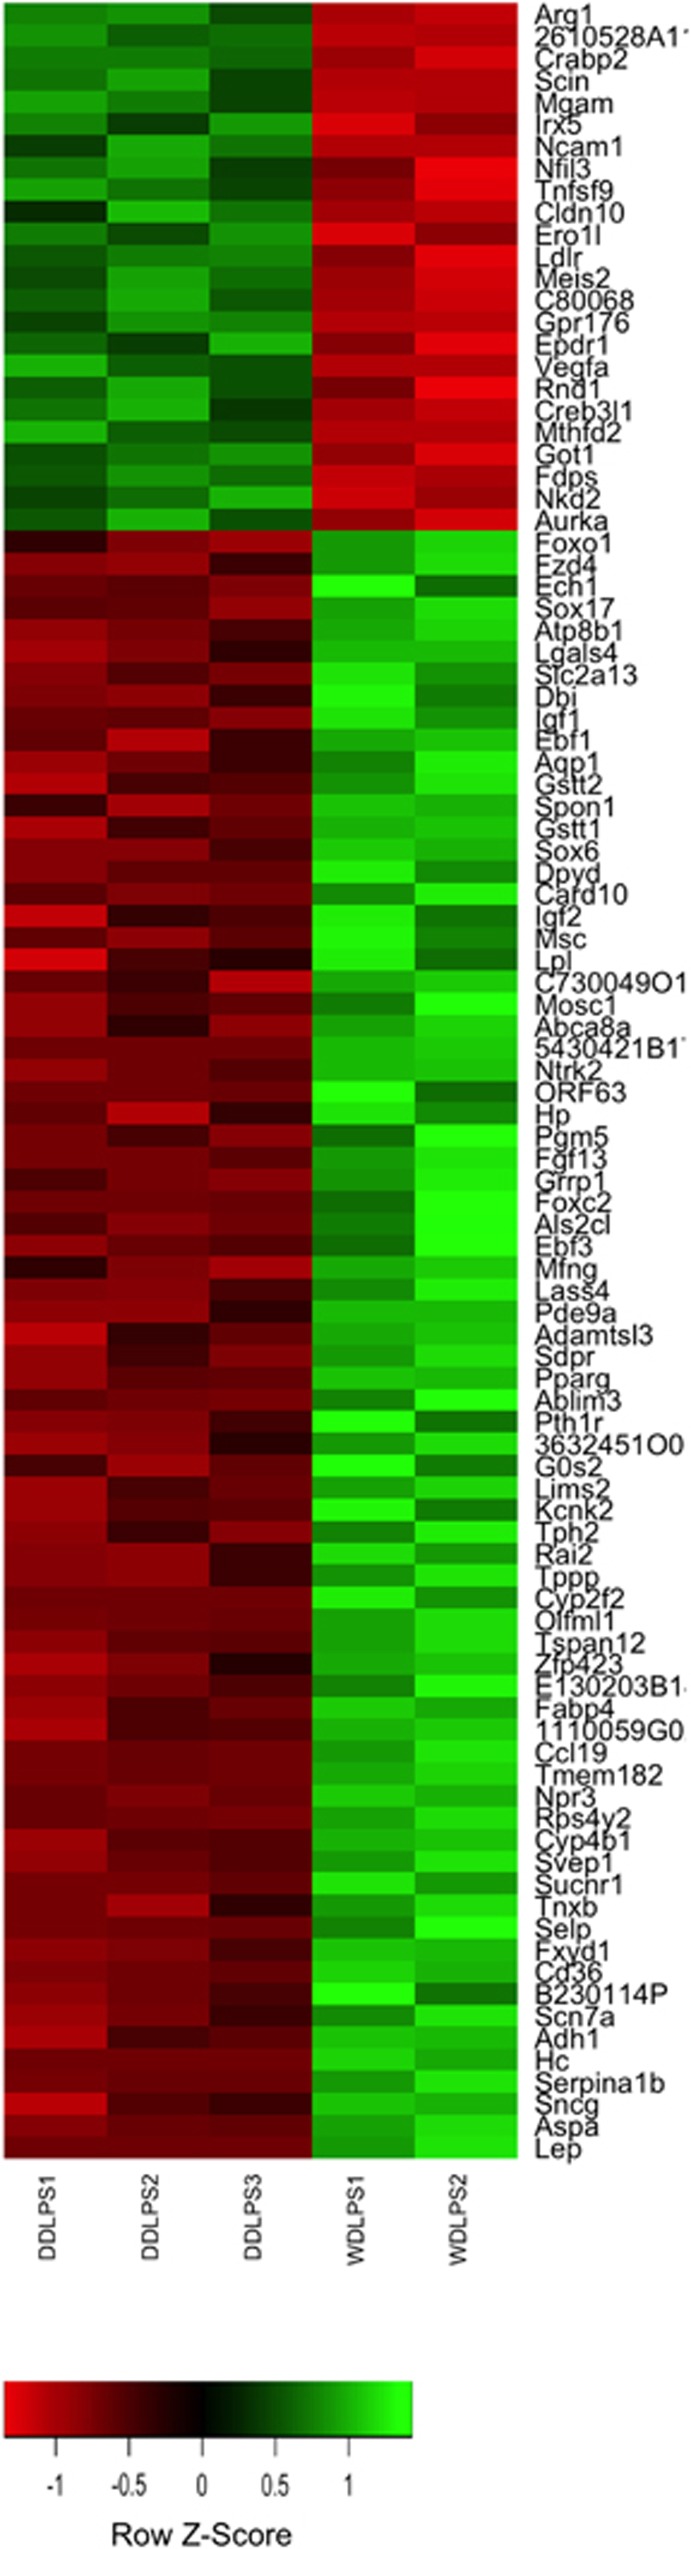
Heat Map of differentially expressed genes between WDPLS and DDLPS. The heat map was generated using genes with P-value ≤0.01 (uncorrected) and fold change >3